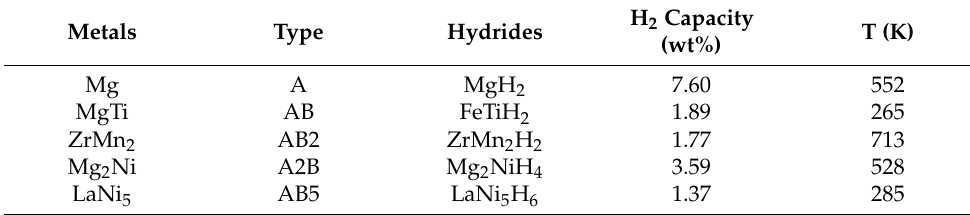
Table 5. Summary of largely available metal hydrides with their